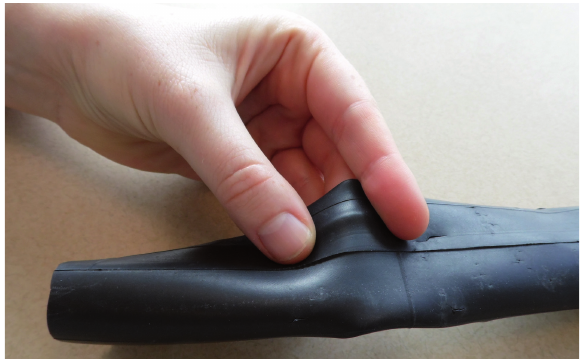
Figure 3 - The three-finger grasp.